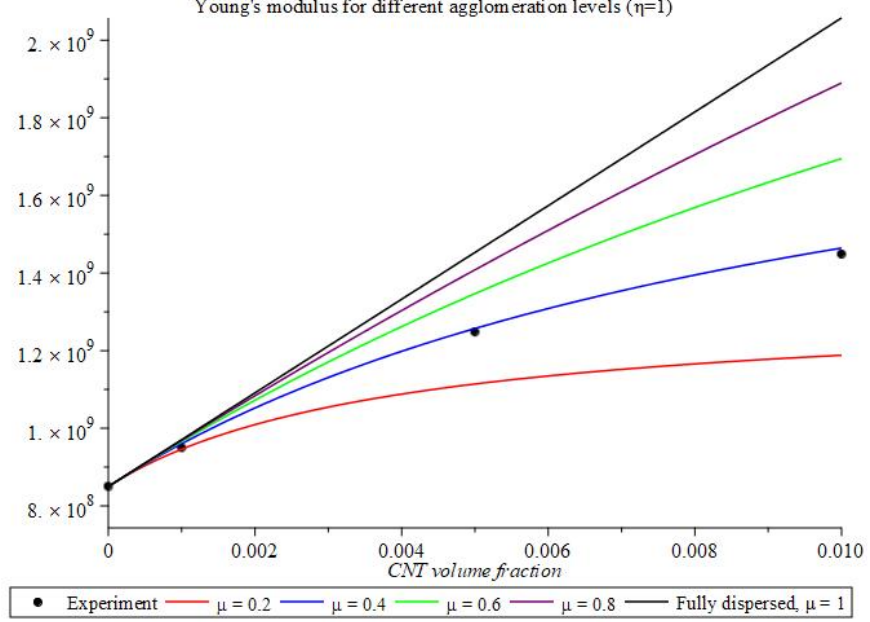
(cid:48) s modulus for di ff erent levels of agglomeration and CNT volume Figure 4. Young ′ s modulus for different levels of agglomeration and CNT volume fraction. Figure 4. Young